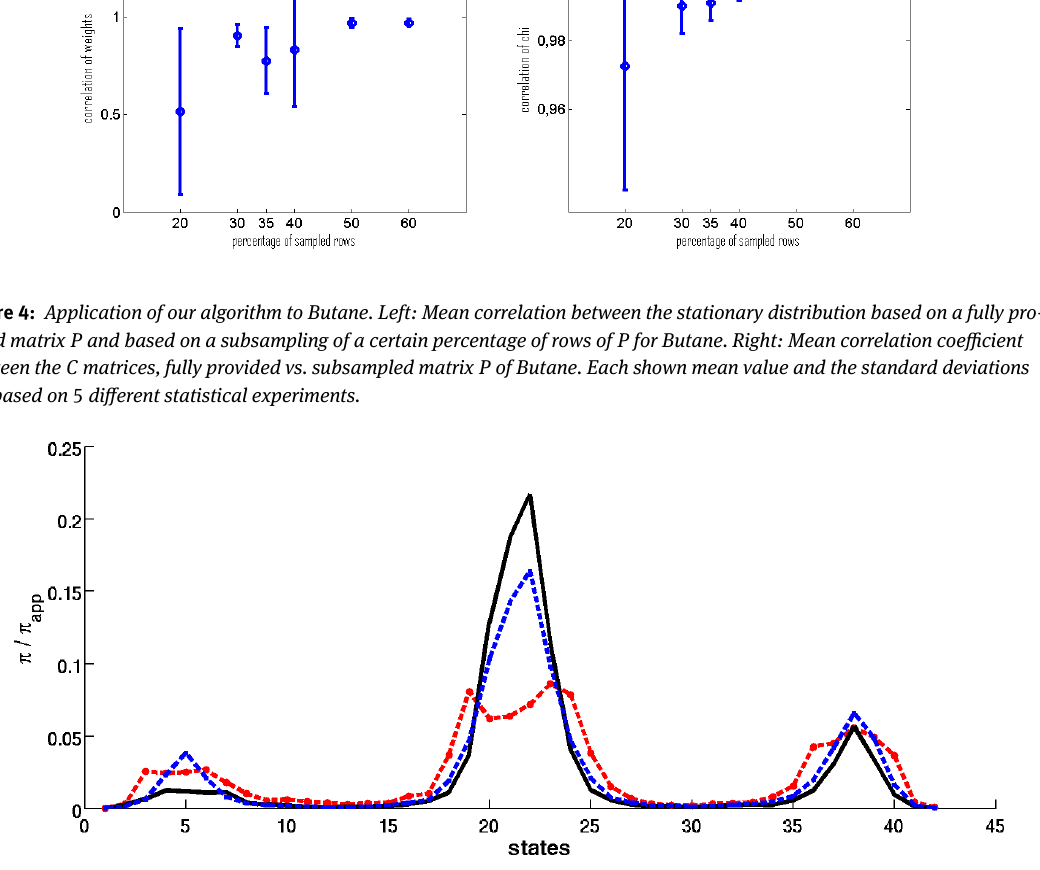
Figure 5: Estimated stationary distribution of Butane: The solid line represents the true distribution π computed by the full matrix P. The dashed-circle line is π app with 30% sampled rows, and the dashed-star line maps π app with 60% sampled